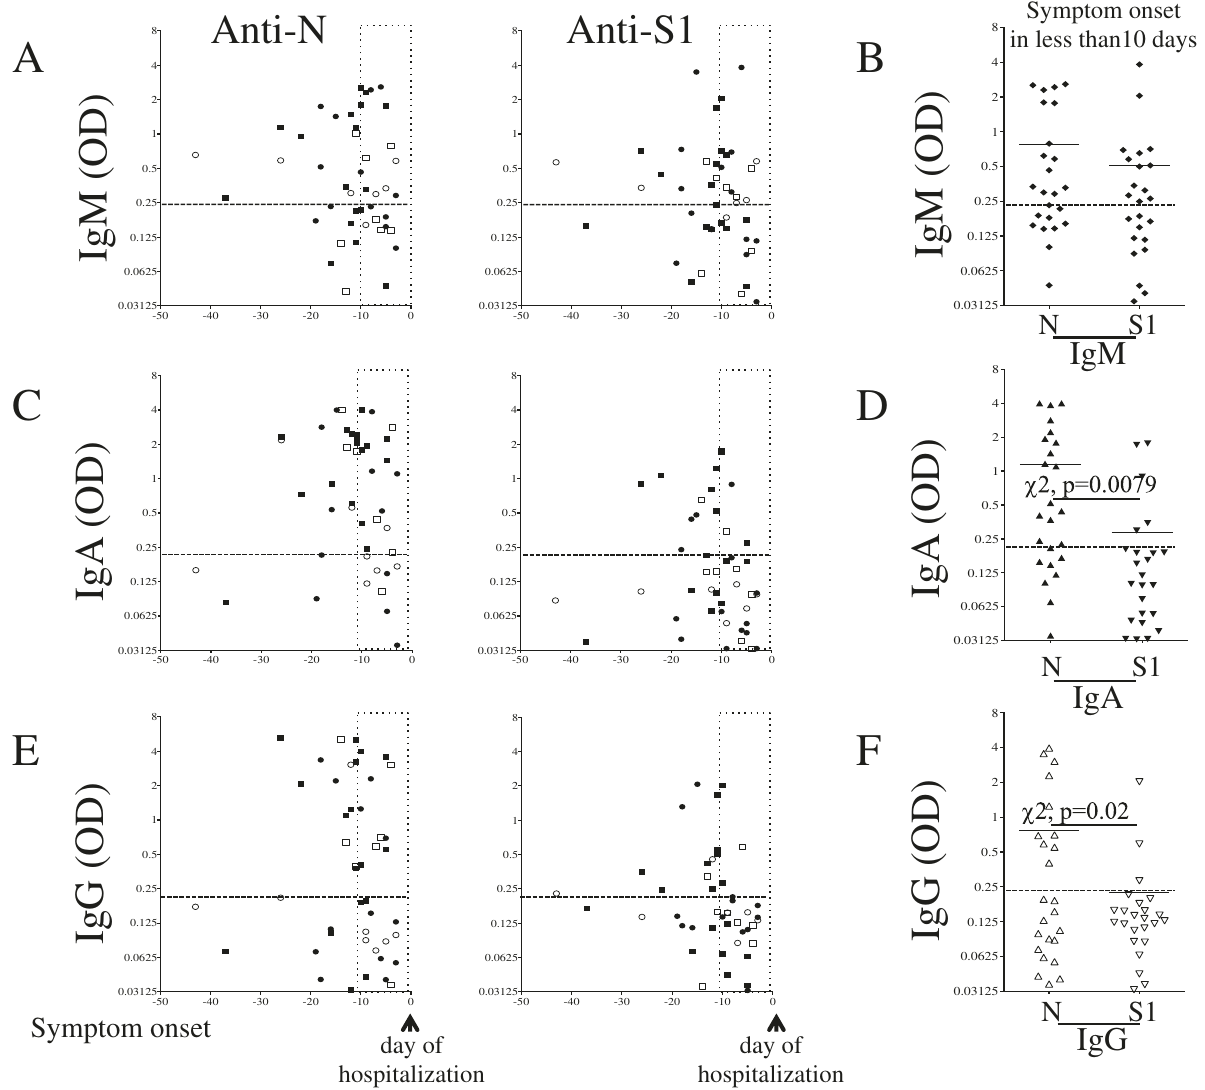
Fig. 3 Symptom onset and humoral response. A, B IgM, C, D IgA, and E, F IgG responses against nucleocapsid (N) and spike (S1) proteins. Values are derived from Fig. 1. Each dot represents an individual. Black symbols are ICU patients, white symbols are non-ICU patients. Circles are females and squares are males. B IgM (diamonds), D IgA ( fi lled symbols), and F IgG (blank symbols) responses in individuals for whom symptom onsets were less than 10 days. Horizontal dashed line indicates the limit of speci fi city and the vertical dashed line shows 10 days before the day of hospitalization. A chi-squared test ( χ 2 test) was used to compare the frequencies of responders. probably too strong to monitor differences between patients showing low levels of avidity index (AI) in the early phase of infection (AI was <0.2). We treated COVID-19 patients ’ plasma with increasing urea-based denaturing solution (1.5, 3, and 6 M) (Fig. 6A). The highest concentration of urea (6 M) completely inhibited antigen-antibody binding in ICU patients, whereas the lower concentration (1.5 M) was not strong enough to impair the binding interaction. Therefore, 3 M was used to measure AI. The binding of speci fi c anti-S1 IgG was signi fi cantly reduced in the presence of 3 M urea (Fig. 6B). Patients included were those who displayed a magnitude of anti-S1 IgG higher than 0.6 OD at 1/400 dilution to prevent a bias in the AI calculation. Non-ICU patients displayed a statistically signi fi cant higher AI compared to ICU patients (Fig. 6C). Age or gender did not correlate with the AI (Fig. 6D) in these 11 patients. The AI values increased in Week 4 compared to Week 2 and remained higher in non-ICU patients than in ICU patients (Fig. 6E). Thus in contrast with the acute phase Cell Death and Disease (2022)